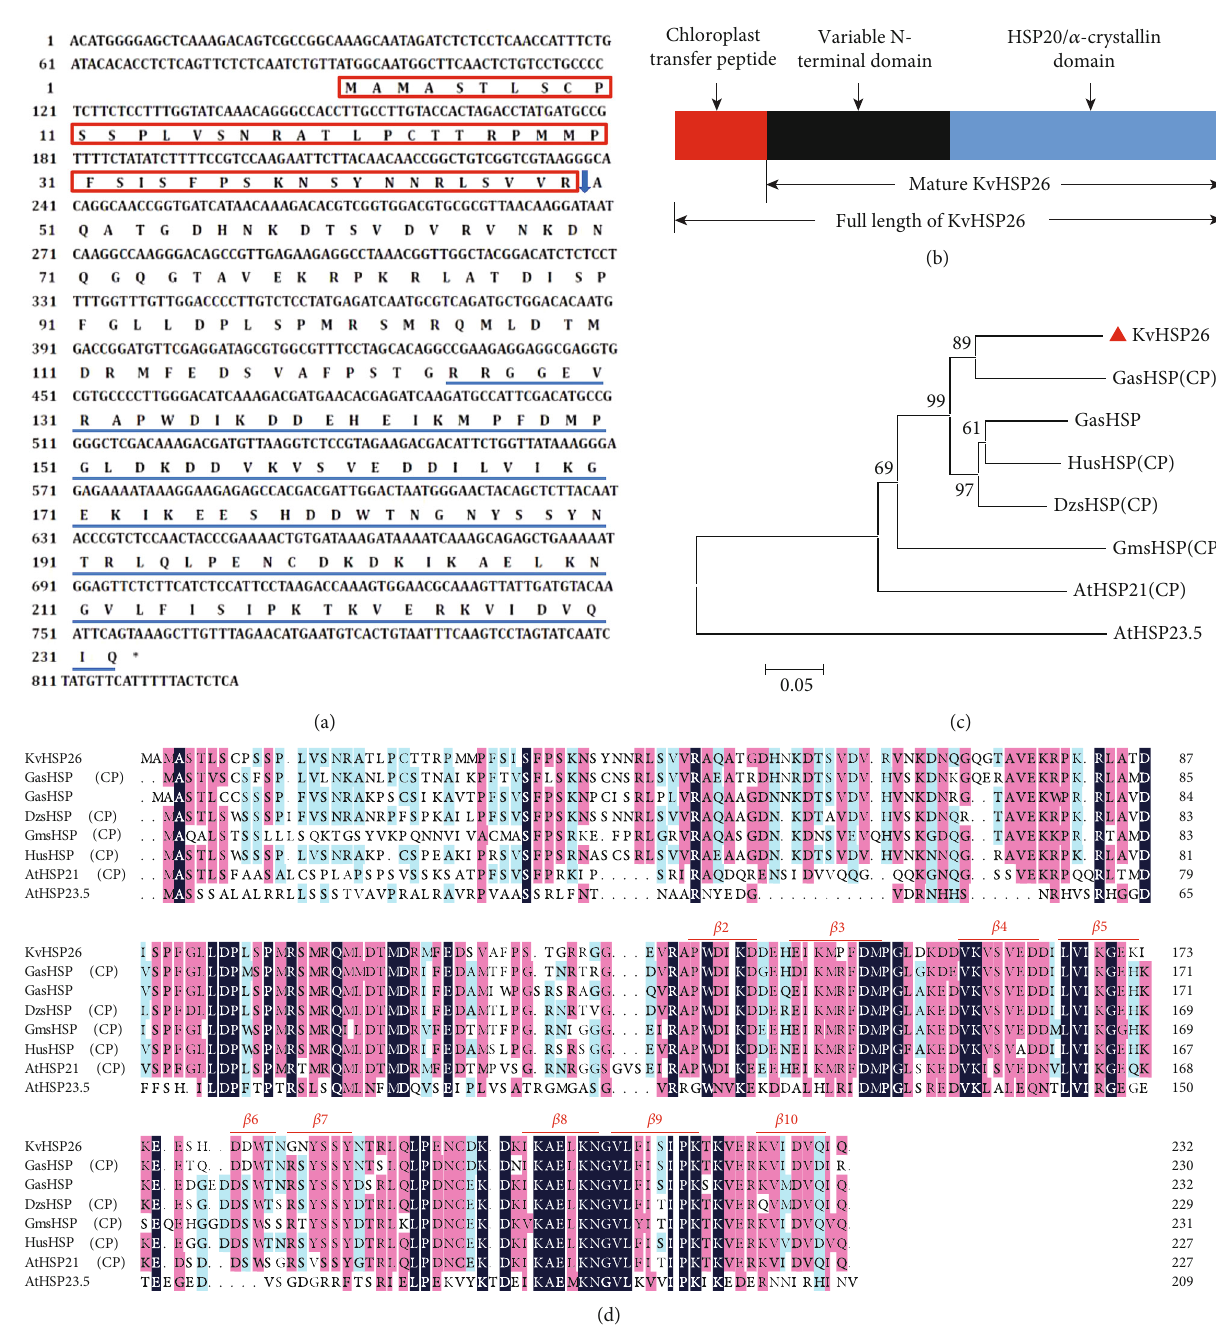
Figure 1: Sequence, conserved domain, multiple sequence alignment, and phylogenetic analyses of KvHSP26. (a) The full-length nucleotide and predicted amino acid sequences of KvHspP26 gene. Each amino acid and its corresponding sequence to its encoding codon were listed. The amino acid sequence corresponding to the chloroplast transfer peptide was shown in a red frame, and the splice site was indicated with a solid blue arrow. The amino acid sequence standing for the conserved HSP20 domain in the C-terminal was underlined in blue. (b) Predicted KvHSP26 protein. (c) Phylogenetic tree of KvHSP26 (MT820948) and sHSPs from other plant species. GasHSP (CP): chloroplastic-like small heat shock protein of Gossypium arboretum (NP_001316945.1); GasHSP: small heat shock protein of Gossypium arboretum (KAA3470224.1); HusHSP (CP), chloroplastic small heat shock protein of Herrania umbratica (XP_021290181.1); DzsHSP (CP): chloroplastic small heat shock protein of Durio zibethinus (XP_022734027.1); GmsHSP (CP), chloroplastic small heat shock protein of Glycine max (NP_001347237.1); AtHSP21 (CP): heat shock protein 21 of Arabidopsis thaliana (NP_194497.1); AtHSP23.5: heat shock protein 23.5 of Arabidopsis thaliana (NP_199957.1). (d) Amino acid sequence alignment of KvHSP26 with its orthologous and paralogous sHSPs from other plant